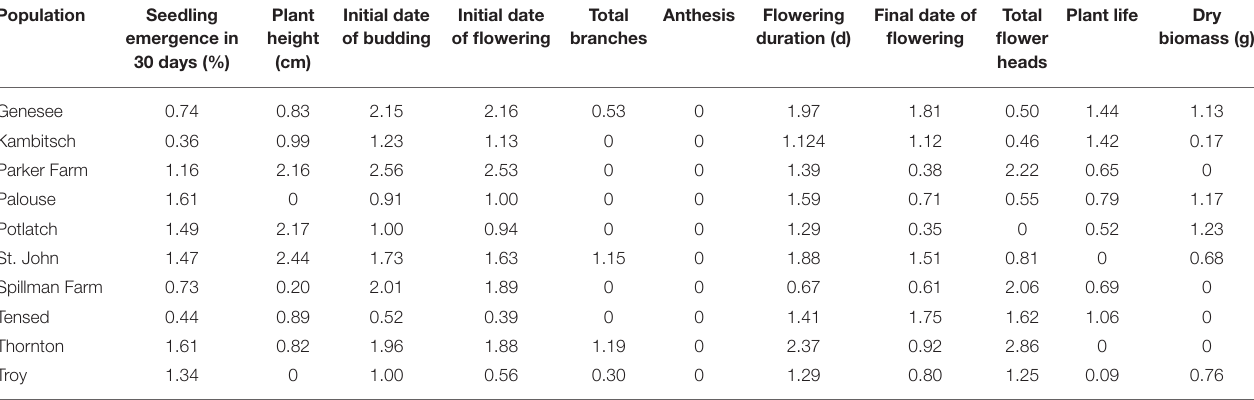
TABLE 5 | Heritability ( h 2 ) estimates of 11 phenotypic traits for half-sib families from 10 Anthemis cotula populations. Population